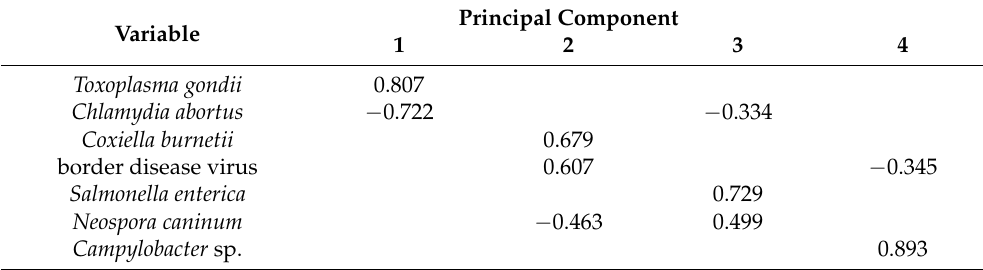
Table 3. Rotated component matrix of pathogens identified in ovine abortions: loadings of principal components 1, 2, 3 and 4 on variables related to absence/presence of pathogens in ovine samples. Coefficients below 0.3 (absolute value) have been suppressed for easier